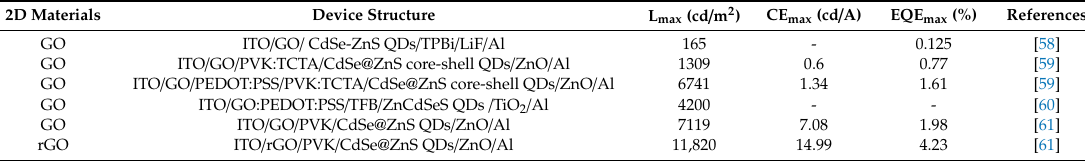
Figure 5. Schematic structures of quantum dot light emitting diodes (QLEDs), in which quantum dots as EML and 2D materials as ( a ) HTL, ( b ) HIL, ( c ) dopant in HTL. Table 3. Summary of the device parameters of QLEDs incorporating 2D materials.